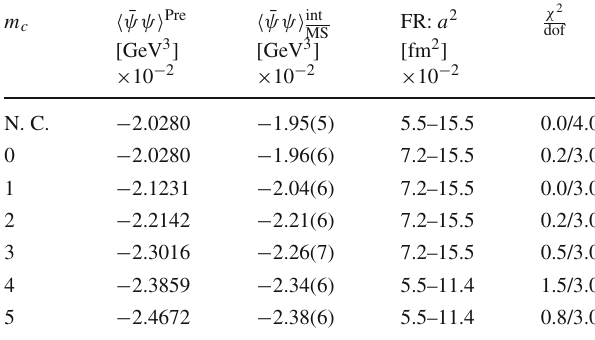
Table 16 The prediction (cid:5) ¯ ψψ (cid:6) Pre , interpolated results (cid:5) ¯ ψψ (cid:6) int continuum limit by the constant function, and the fitting